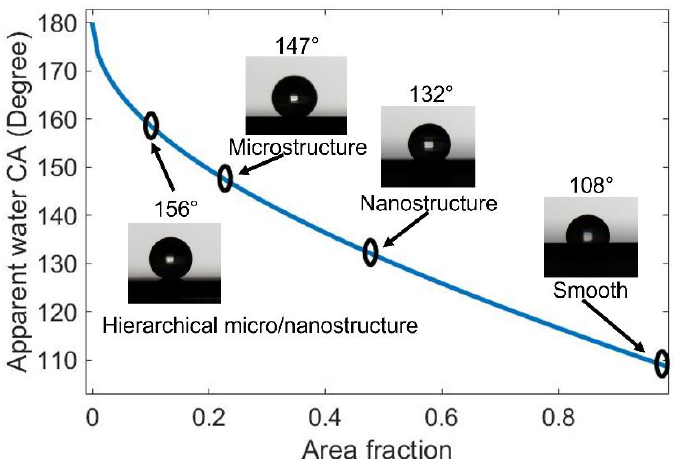
Figure 6. The equilibrium contact angle of waterdrop on four different surfaces compared with the theoretical Cassie state curve. theoretical Cassie state